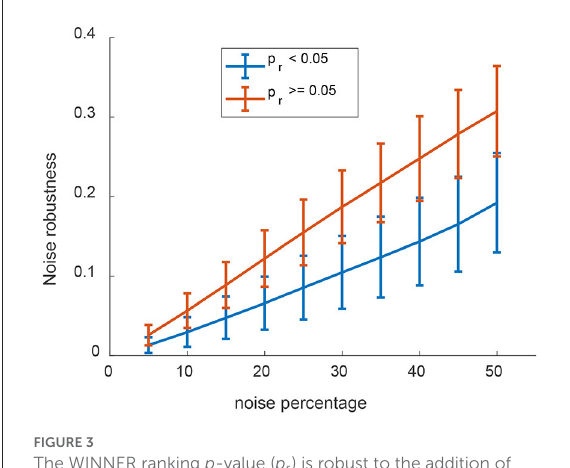
FIGURE3 The WINNER ranking p -value ( p r ) is robust to the addition of noise (STATS?). Genes in all KEGG pathways were ranked via WINNER, and WINNER ranking p -values ( p r ) were calculated, after varying degrees of noise were added to the network; then, noise robustness was compared for genes with p r < 0.05 and p r